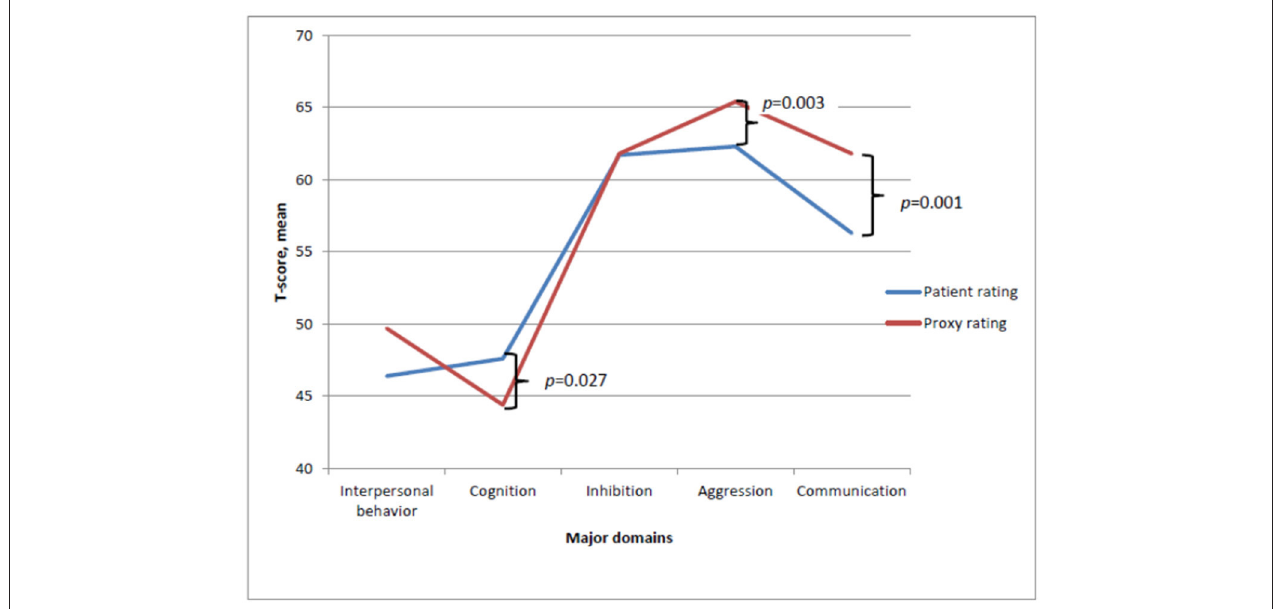
FIGURE 2 | Mean T -score ratings completed by patient and proxies on the major domains of SASNOS. Significant difference between patient and proxy ratings on the major domains Cognition, Aggression and